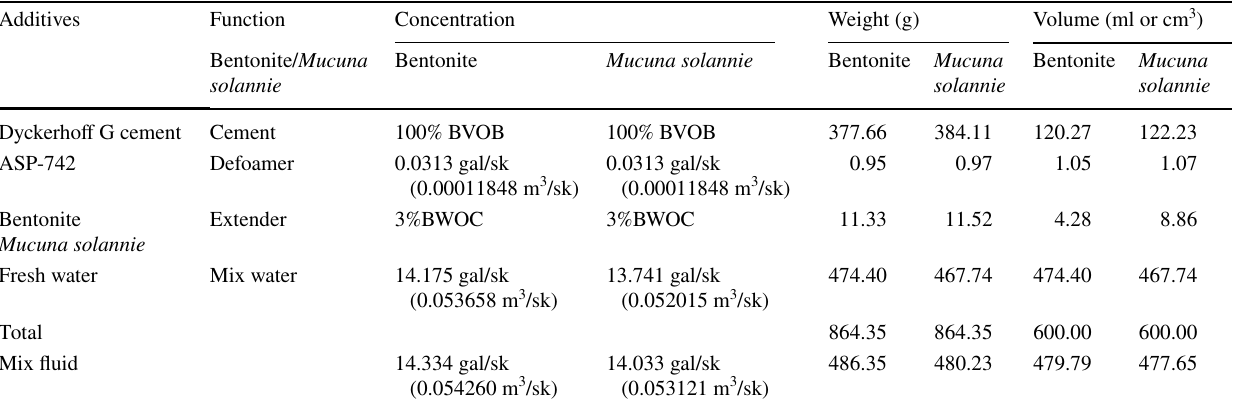
Table 3 Bentonite and Mucuna solannie extenders slurry formulations